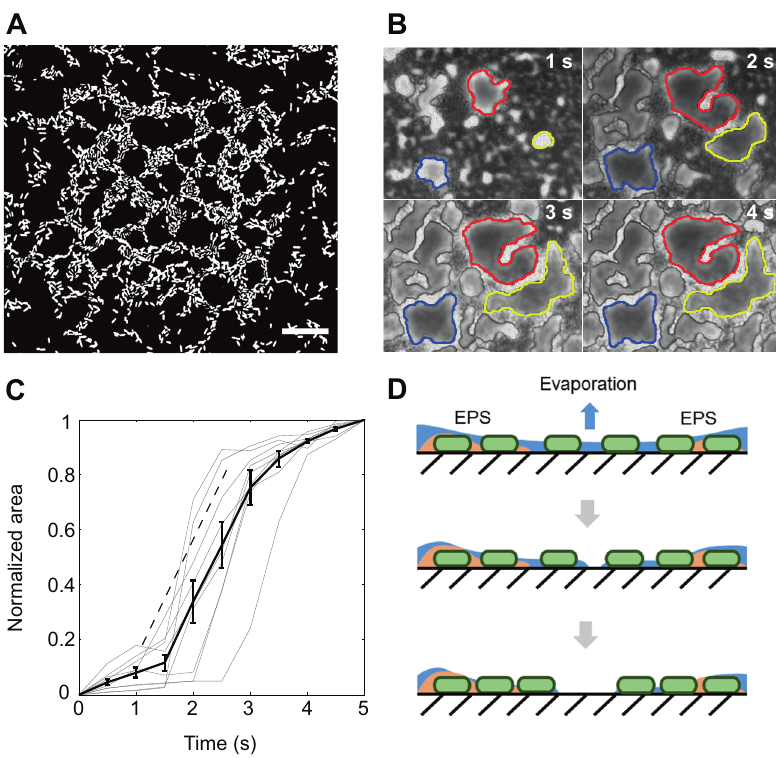
Fig. 3 Bio fi lm holes and hole formation dynamics. a Close-up view (×60 objective) of the bacterial distribution in an originally 100 2 µm 2 bio fi lm patch, after the passage of an air bubble. Scale bar, 20 µm. b Zoomed-in view of the dynamics of hole formation at 1 s intervals. The boundaries of three holes are identi fi ed with red , blue and yellow at each of the four time points. Scale bar, 10 µm. c Time course of the area of the nine holes in the image shown in ( b ) ( faint gray lines ) along with their average ( thick black line ). The area of each hole was normalized by its maximum value. The dashed line denotes a linear slope. Error bars correspond to the standard error of the mean. d Schematic of bacterial repositioning by the action of the evaporating thin liquid